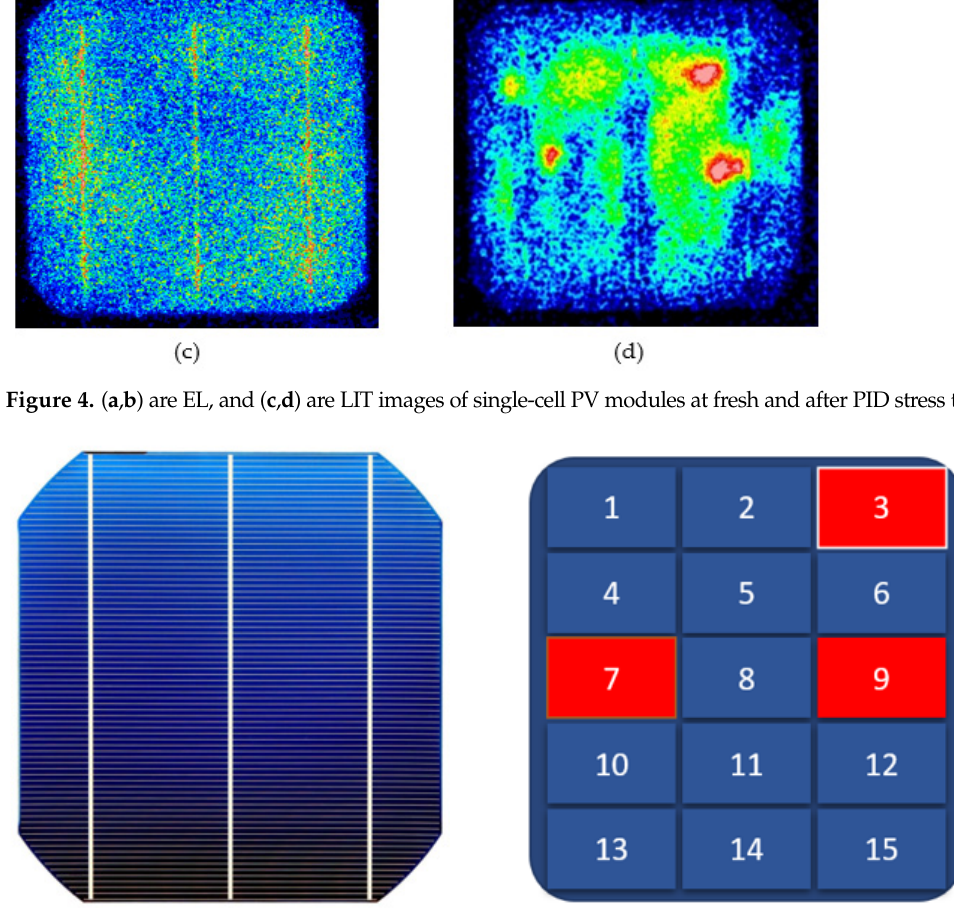
Figure 4. ( a , b ) are EL, and ( c , d ) are LIT images of single-cell PV modules at fresh and after PID stress test.